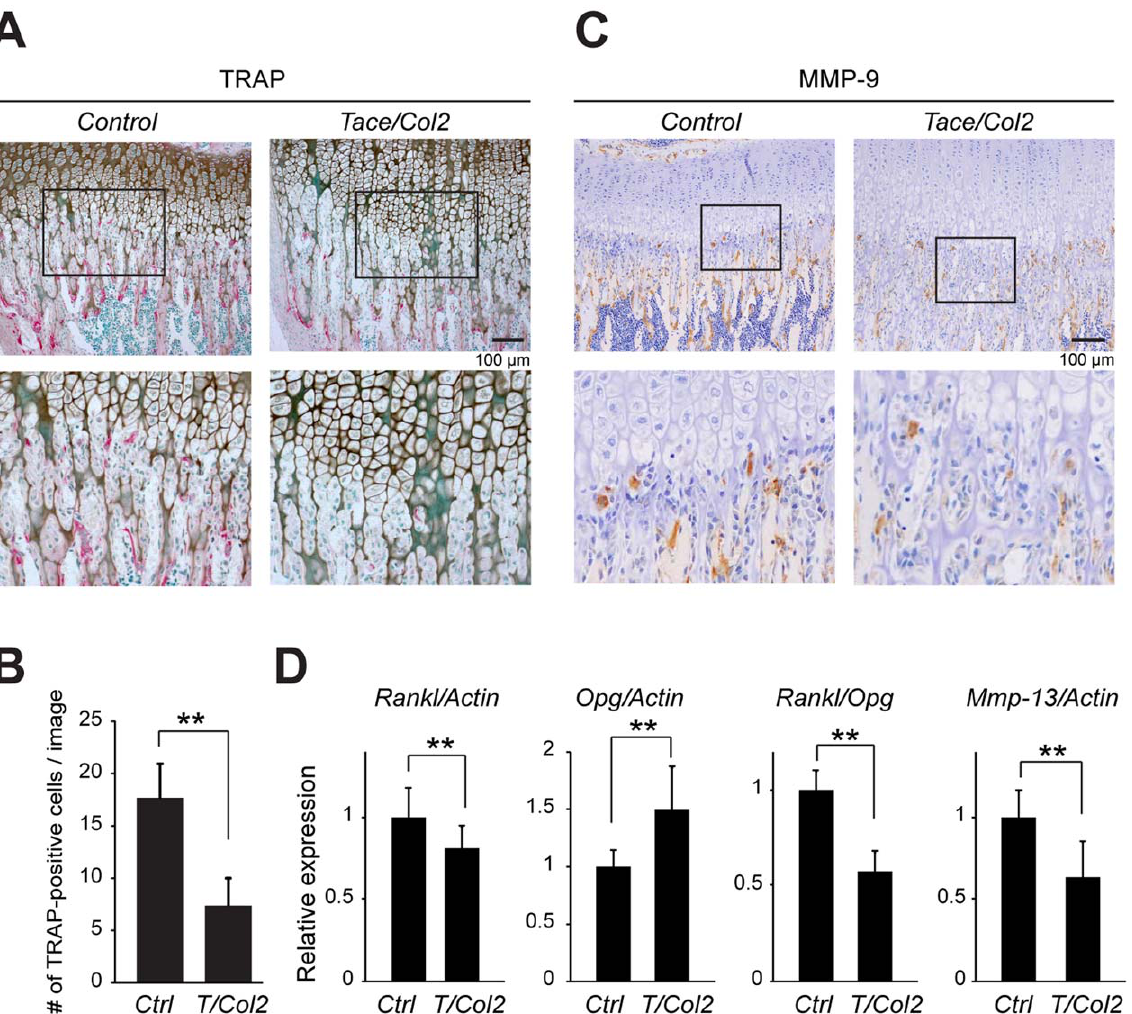
Figure 3. Fewer osteoclasts at the chondro-osseous junction of the growth plate in Tace/Col2 mice. Tibia sections from 3-week-old Control and Tace/Col2 mice stained for TRAP (A) or MMP-9 (C). The lower panels show high-magnification images of the boxed areas in the upper panels. (B) The number of TRAP-positive cells adjacent to the chondro-osseous junction per image in 3-week-old Control and Tace/Col2 mice. The results are expressed as the mean 6 SD of at least three mice (two sections from each mouse) in each group. (D) Quantitative analysis of the levels of Rankl , Opg , and Mmp-13 transcripts in the cartilage tissues collected from Control and Tace/Col2 mice. The results are expressed as the mean 6 SD of at three independent experiments. **, p ,